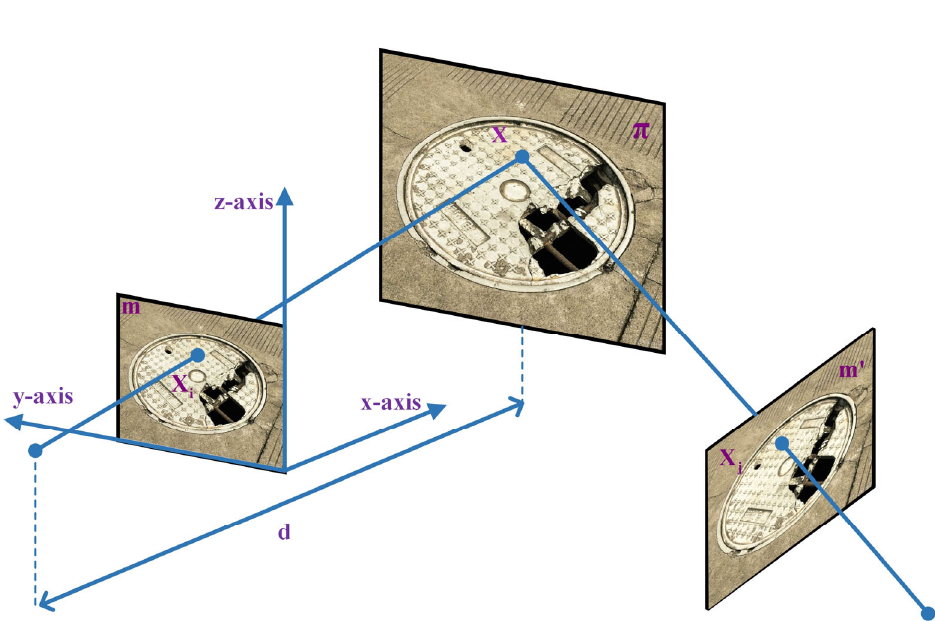
Figure 3. Example of a damaged manhole cover under the mobile equipment coordinate system and vehicle camera coordinate system.